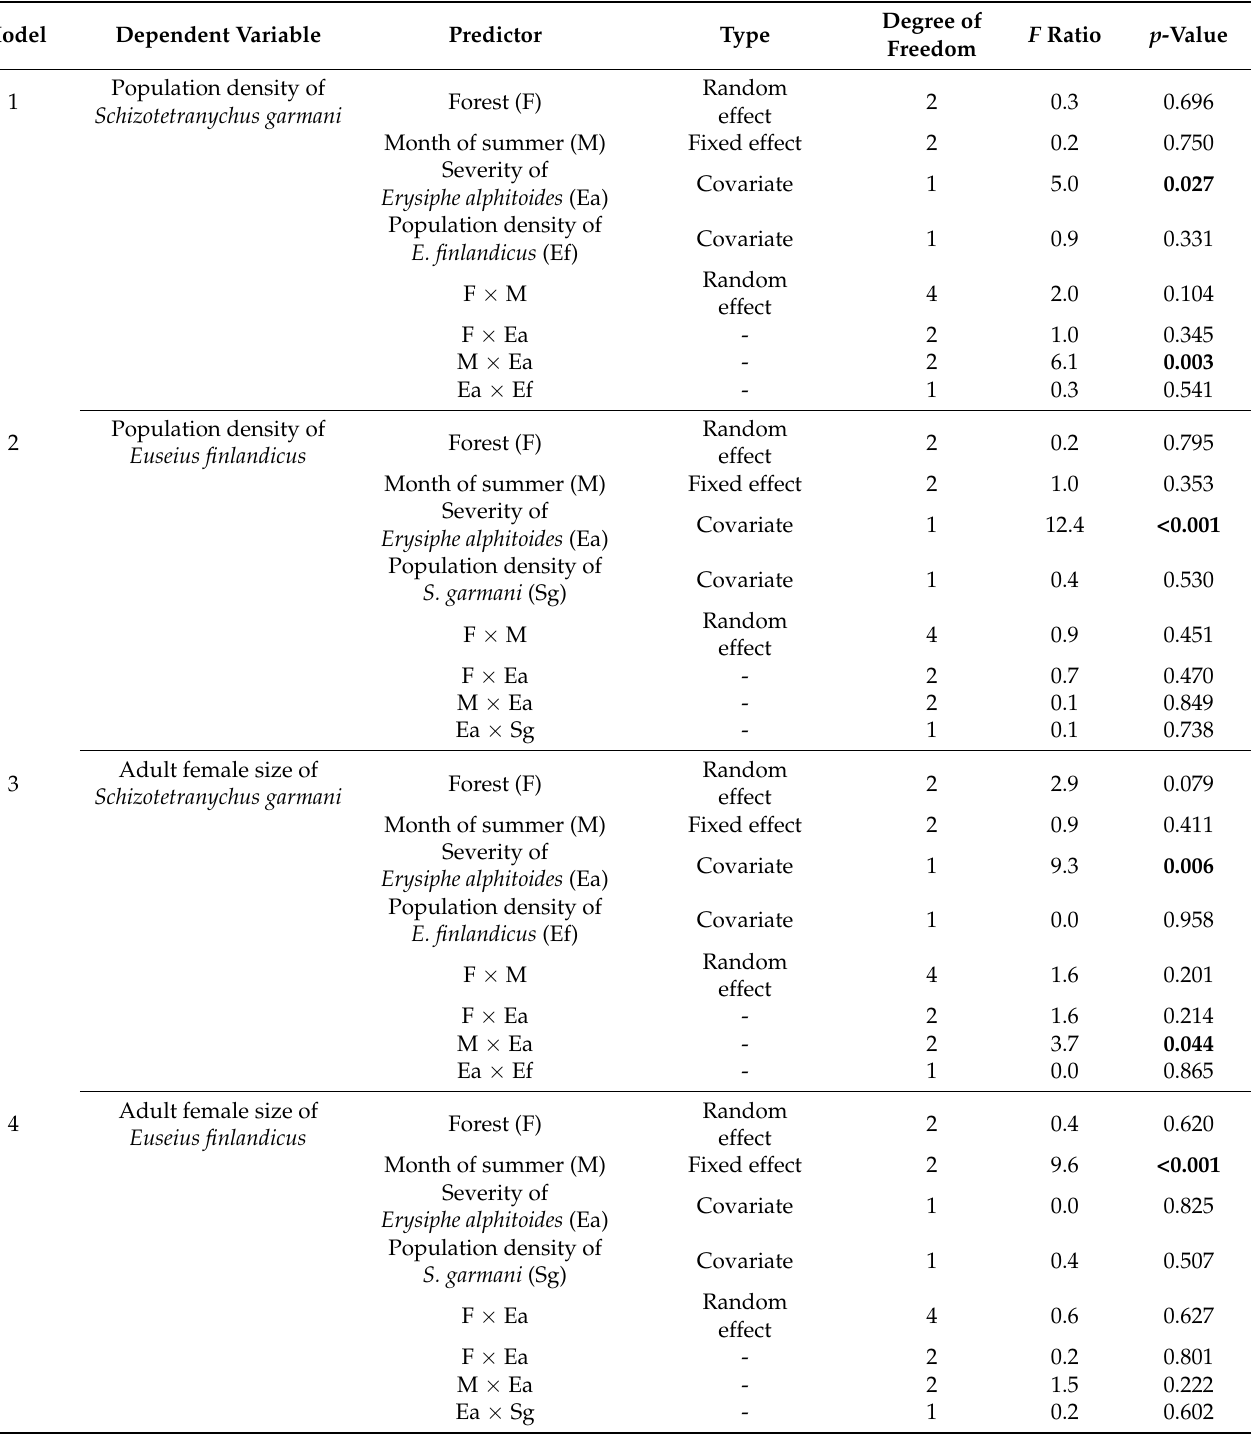
Table 1. Results of the linear mixed models for analysis of relationships and interactions between powdery mildew ( Erysiphe alphitoides ), a phytophagous mite ( Schizotetranychus garmani ) and a predatory mite ( Euseius finlandicus ) in leaves of Quercus robur from three forests, sampled for three months in summer. Significant p -values are indicated in